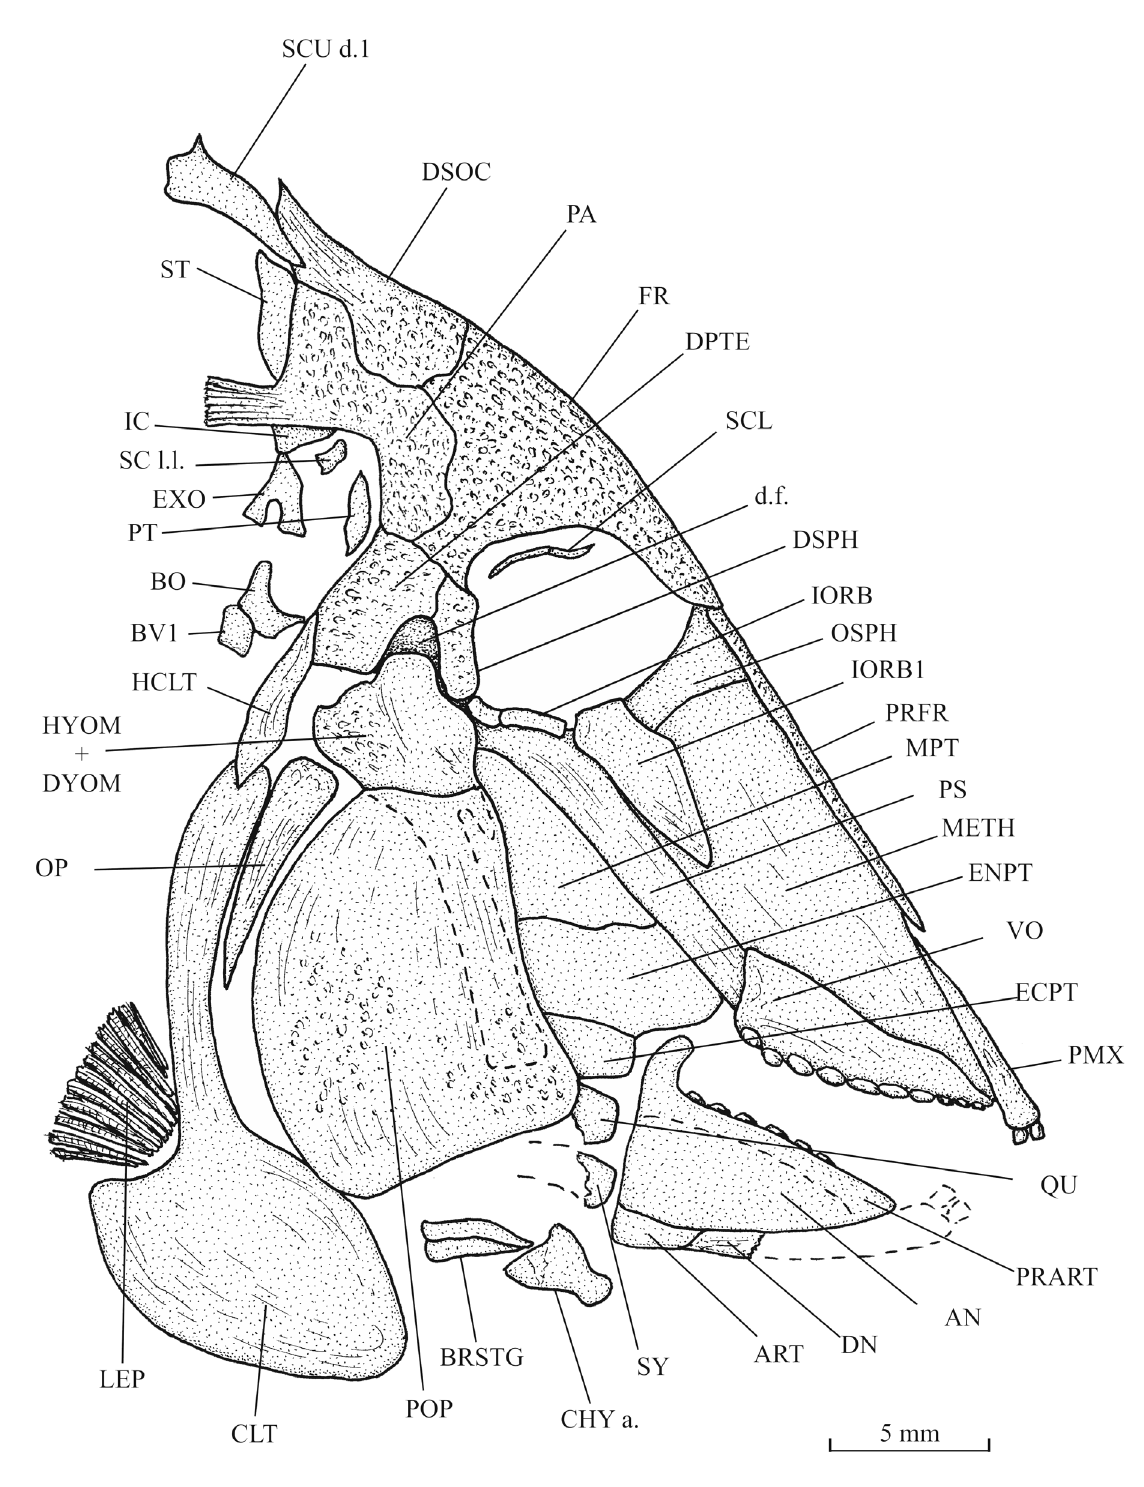
Fig. 4. Libanopycnodus wenzi gen. et sp. nov., holotype, skull and pectoral girdle (CLC S-574).